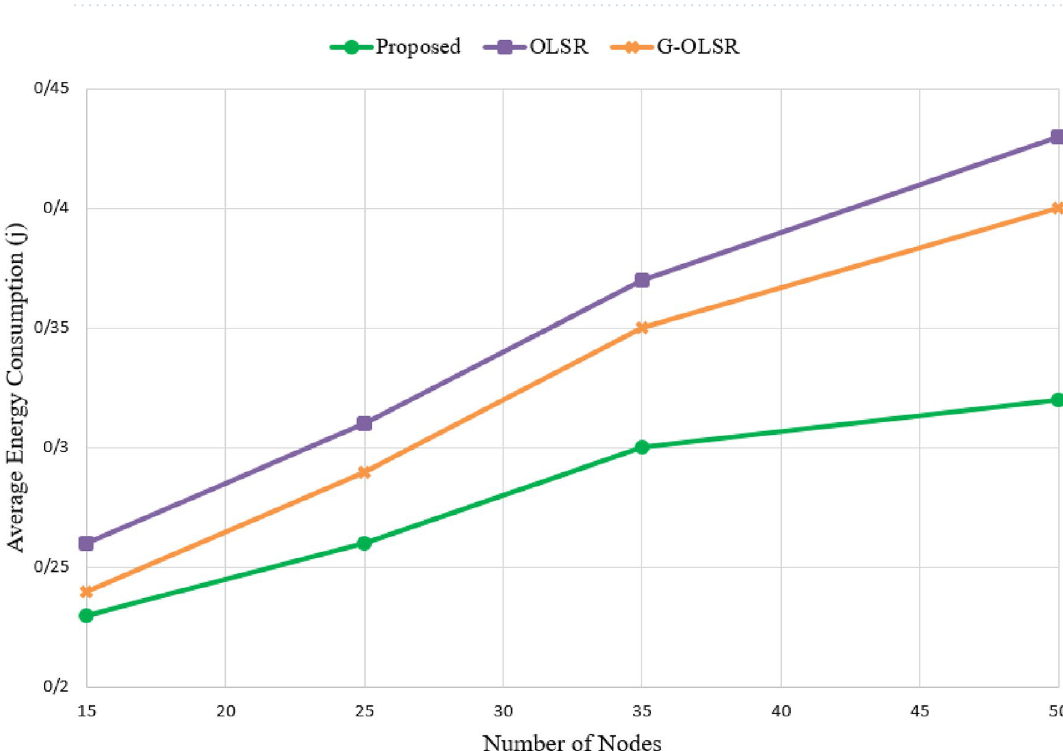
Figure 12. Comparison of different routing methods in terms of energy